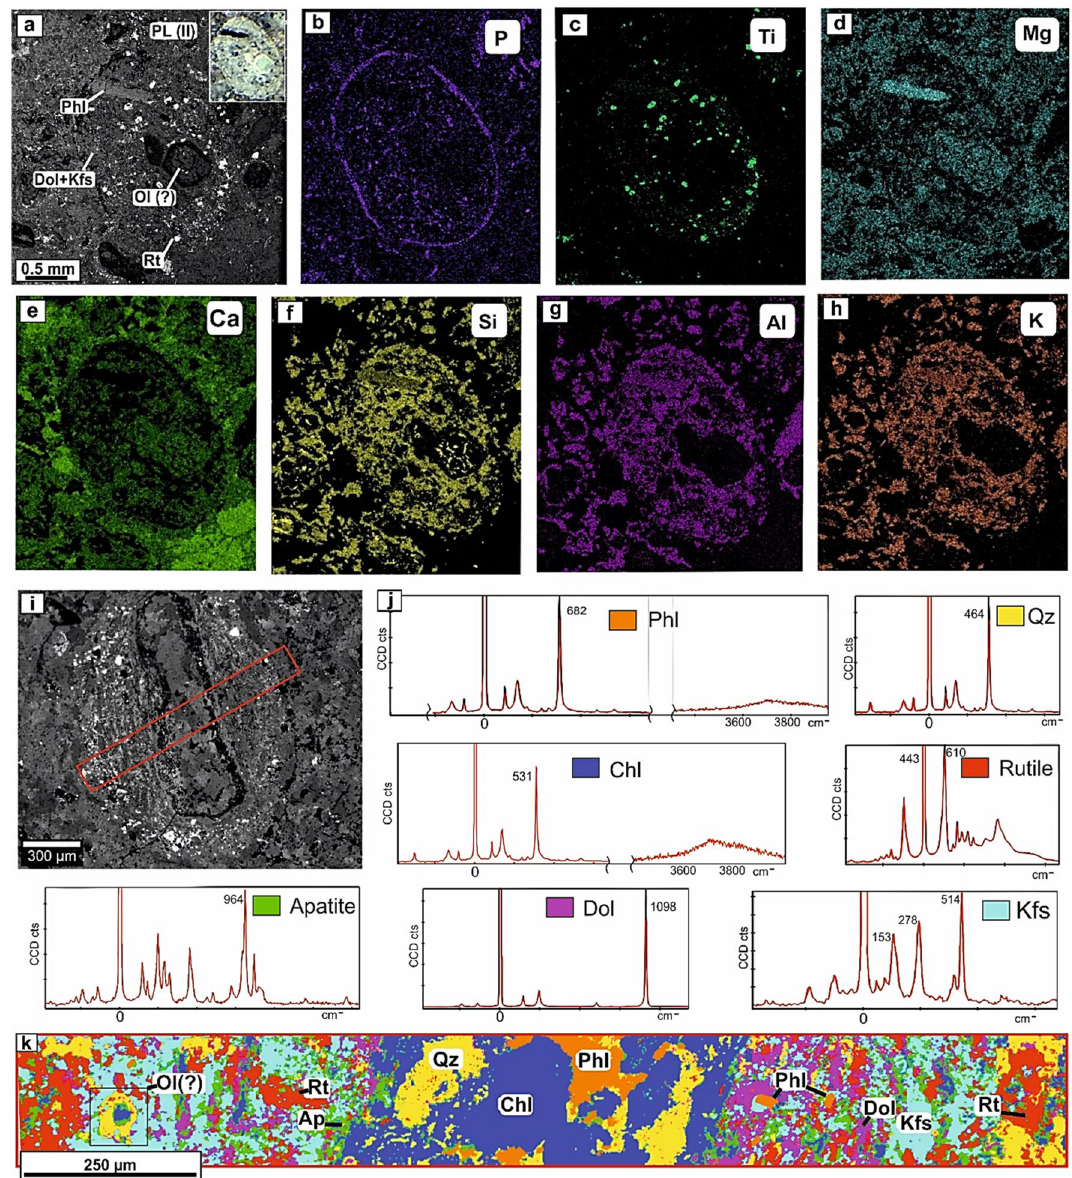
Figure 3. BSE image with a photomicrograph inset of the type II pelletal lapilli (PL-II) ( a ) and the rim composition of the pelletal lapilli-II as observed in SEM elemental mapping with distribution of P, Ti, Mg, Ca, Si, Al and K ( b–h ). Results from the Raman study of type I pelletal lapilli (PL-I) sample: BSE image of PL-I ( i ): Raman spectra of identified crystal phases ( j ) and mineral distribution map of PL-I ( k ) obtained by areal Raman mapping on the highlighted red section in the BSE image ( i ). The figure was created using Corel Draw X4 software https:// www. corel draw. com/ en/ pages/ corel draw-